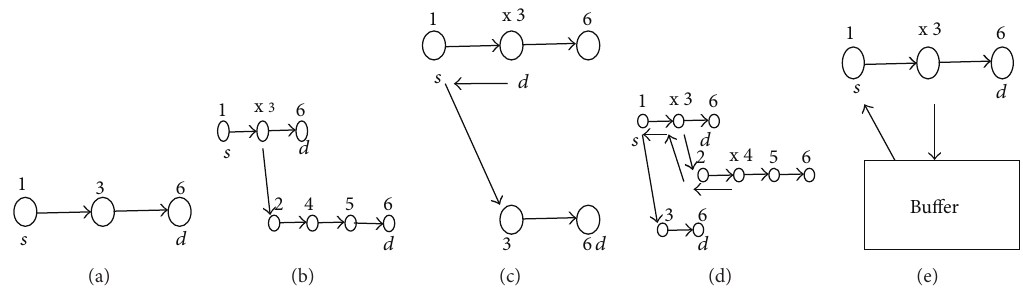
Figure 2: Case (a): normal transmission. Case (b): deflection routing. Case (c): retransmission. Case (d): deflection and retransmission. Case (e): proposed method.